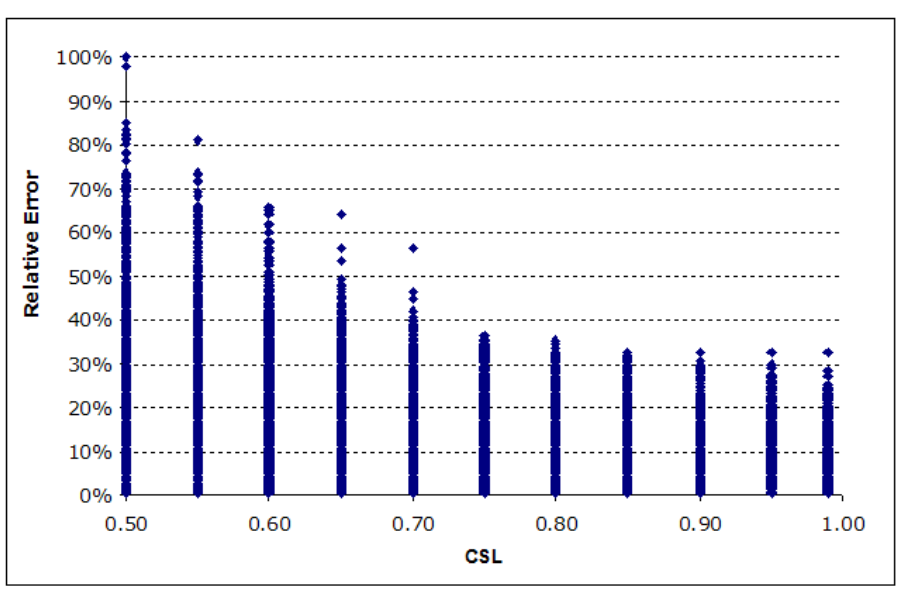
Figure 2. “Relative errors versus the target CSL for the 19.866 resulted